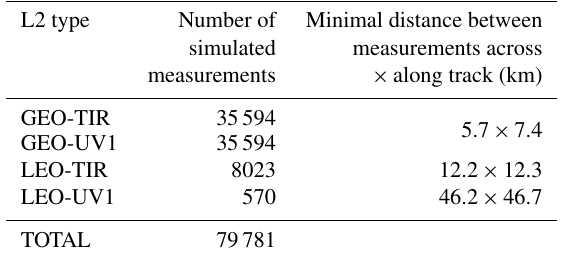
Table 2. Number and horizontal resolution of the simulated mea- surements. For the GEO platform across-track is a south–north di- rection and along-track is an east–west direction.